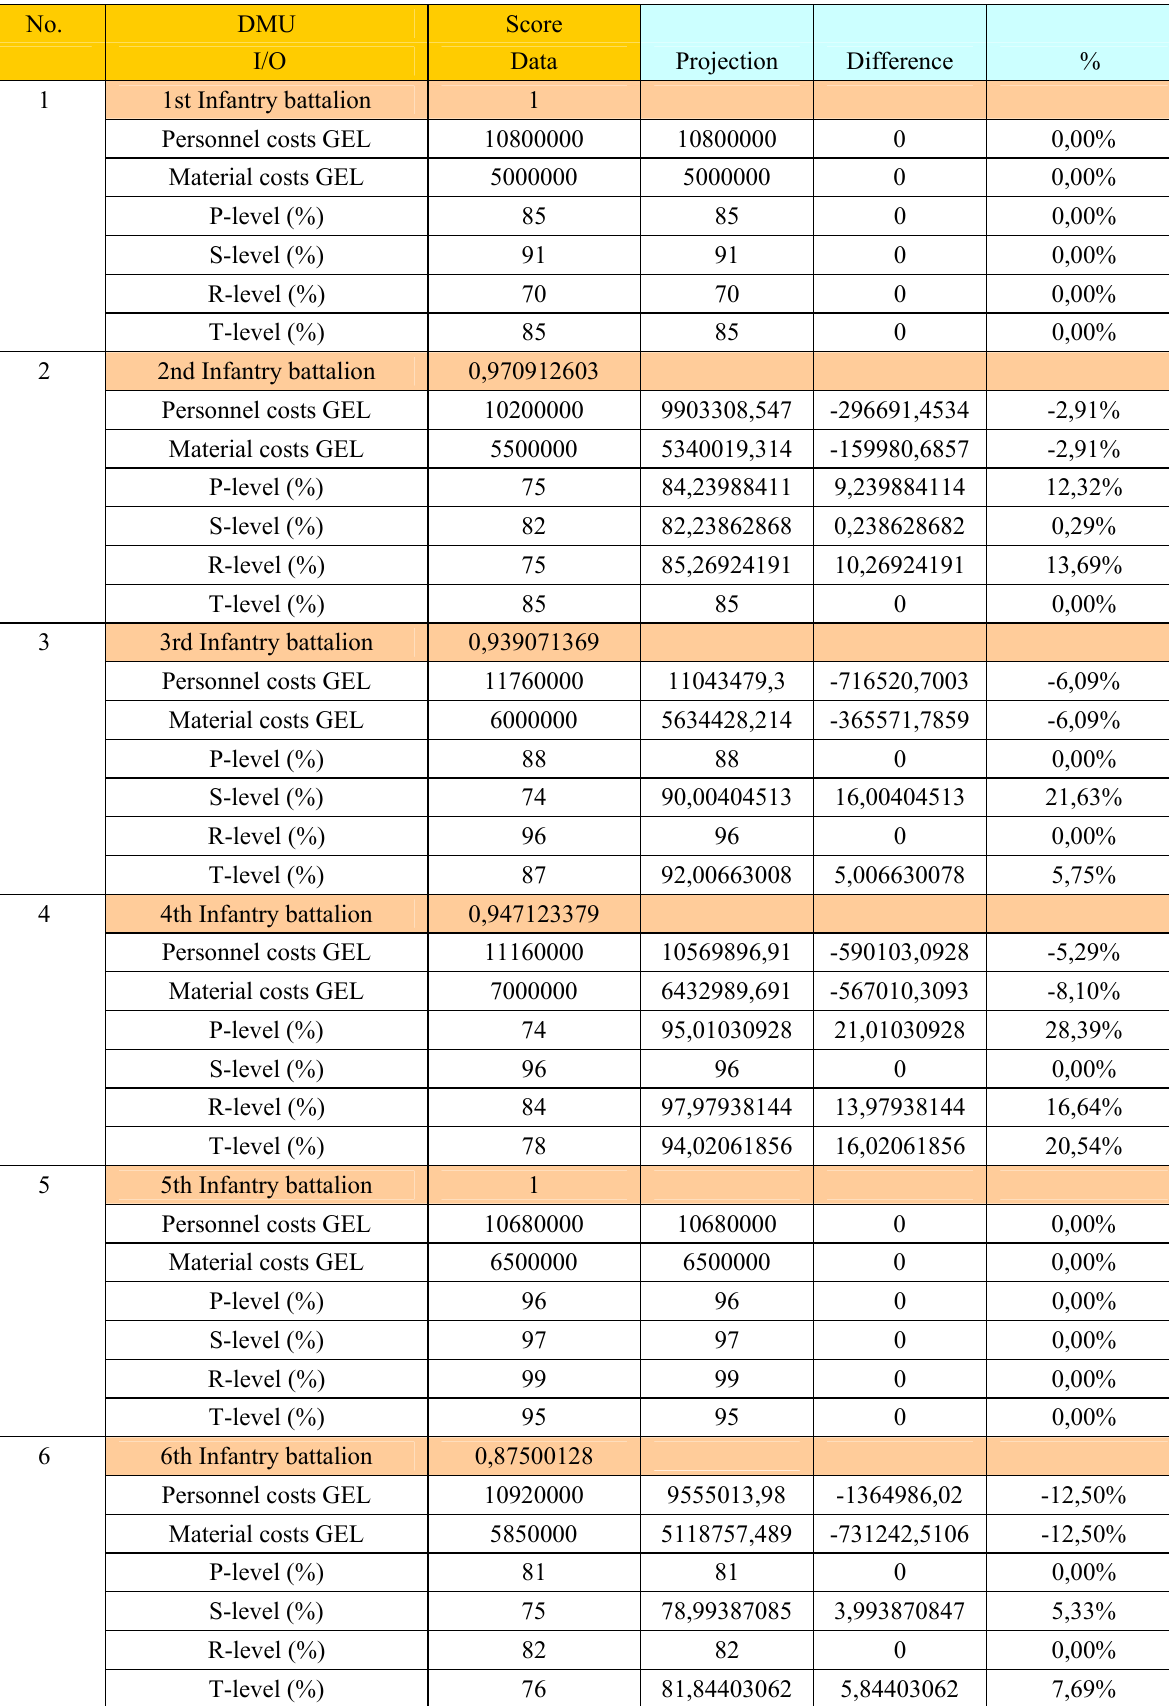
Table 7. Projections by the CCR